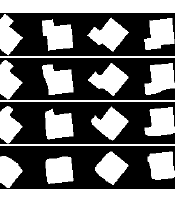
Figure 5. Small building with annex: 1 row: original, 2 row: 1:10k, 3 row: 1:15k, 4: 1:25k